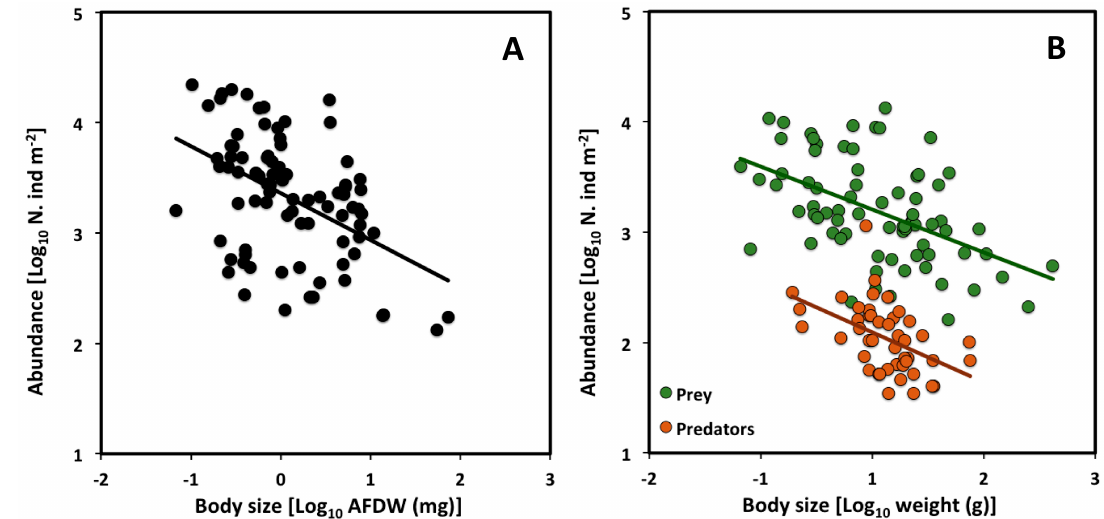
Figure 3. Scaling of population density versus body size (AFDW: ash free dry weight) across macroinvertebrate communities in Mediterranean and Black Sea lagoons (data from [29,30]): A ) CCSR for all assemblages at various sampling sites; ( B ) CCSRs for prey and predators analyzed separately across sampling sites. Note that since the mean body size and population density were analyzed separately for prey and predator species across sampling sites, the number of points are greater and located at di ff erent positions in graph ( A ) vs. graph ( B ). Table 5 . Results of the LSR analyses of log10 population density (number of individuals per m 2 ) in relation to log10 body size (AFDW: ash free dry weight) of macroinvertebrate communities in Mediterranean and Black Sea lagoons (data from [29,30]). CCSR Slope 95% CI Intercept n r 2 p All assemblages − 0.43 − 0.60 to − 0.25 3.36 85 0.22 *** Prey − 0.39 − 0.53 to − 0.24 3.40 75 0.25 *** Predators − 0.45 − 0.78 to − 0.24 2.32 45 0.23 *** *** p < 0.001. Table 6. p values for slope and intercept comparisons of the LSR analyses in Table 5. The differences among slopes were assessed by comparing 95% CI. When the slopes were not significantly different, the differences between elevations were estimated by ANCOVA (with body mass as a covariate). Trophic level p Value for Slope a p Value for Intercept b Prey Predators Prey Predators Prey - ns - *** Predators ns - ***